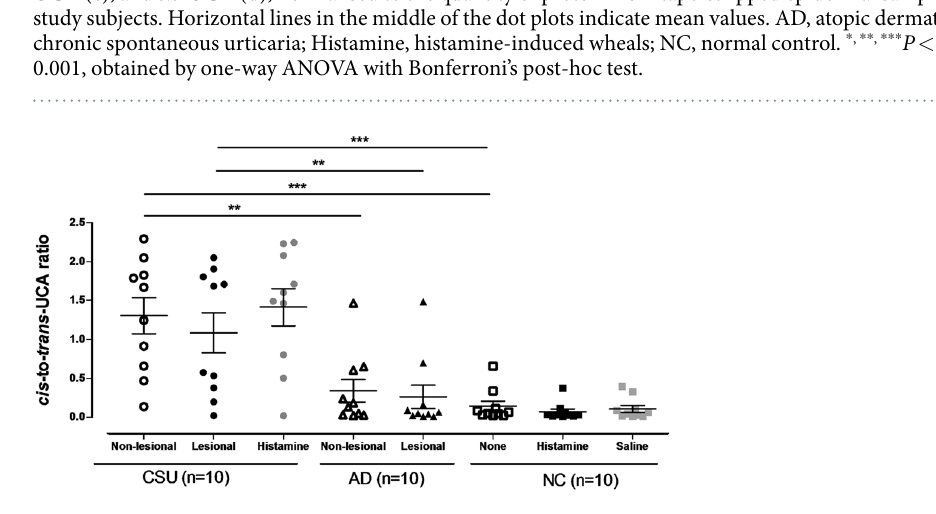
both) and NCs (0.14 ± 0.19; P < 0.001 for both non-lesional and lesional). However, no significant difference in cis -to- trans- UCA ratio was noted between the AD and NC groups. Figure 3 shows the diagnostic values of cis- to trans- UCA ratio in distinguishing CSU from AD patients, using receiver operating characteristic curve. The area under the curve (AUC) for cis- to trans- UCA ratio in lesional skins was 0.850 ( P = 0.008) with a sensitivity of 90% and specificity of 80% at the cut-off value of 0.179.